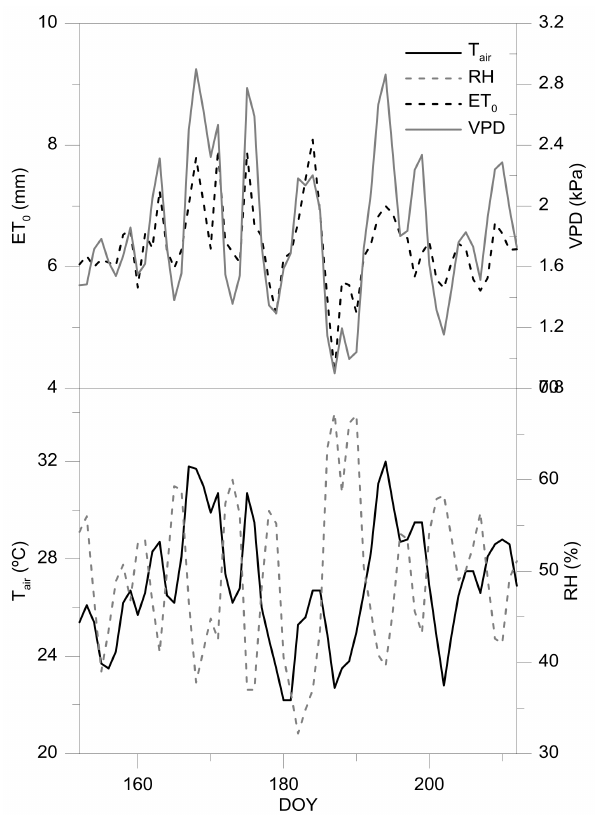
Figure 3. Weather conditions during the experimental period. T air , average air temperature; RH, relative humidity; ET 0 evapotranspiration; VPD, vapour pressure